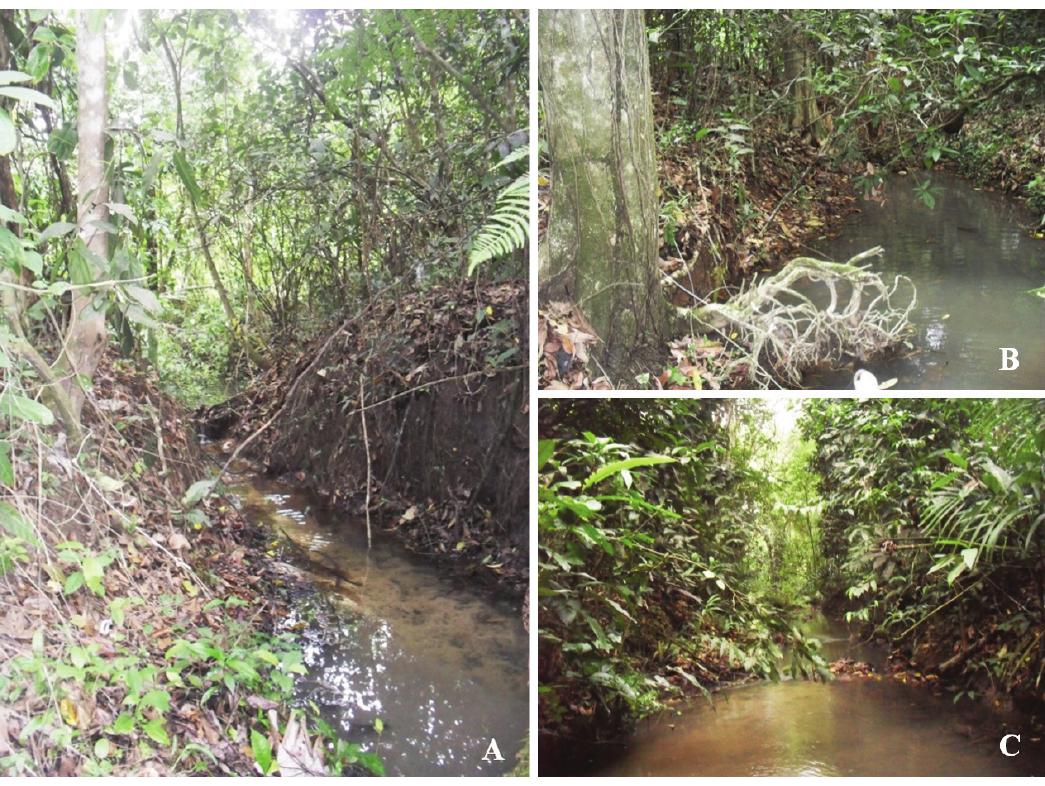
Figure 1. Images of the three blocks A, B and C, respectively, sampled during rainy season in May, 2013 at the stream Saltinho of the Biological Reserve of Saltinho, Tamandare city – Pernambuco, Brazil.